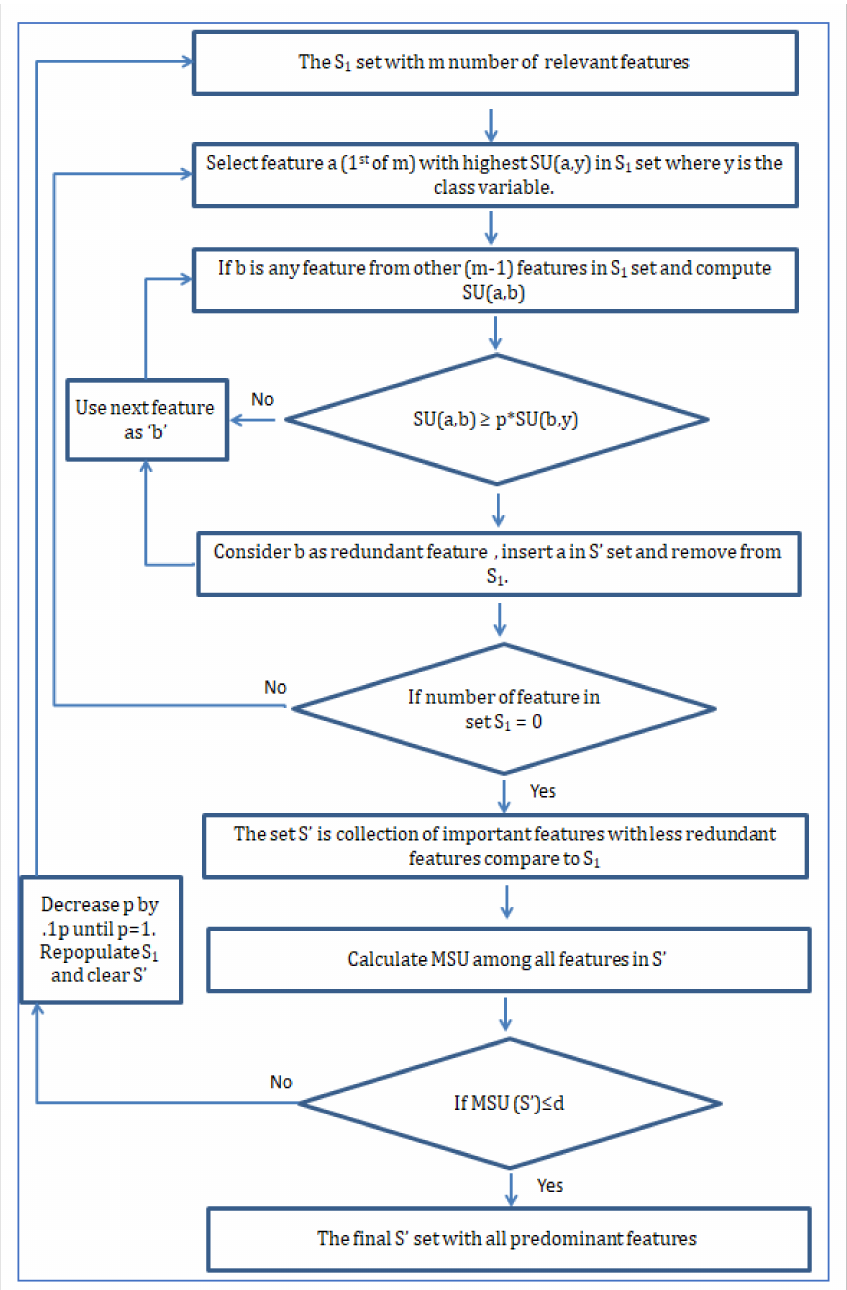
Figure 10. Step 2: Flowchart of fast correlation using SU and MSU to remove redundant